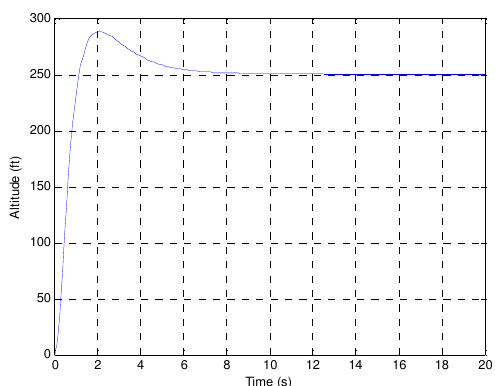
Fig . 9. Airspeed increase by change the throttle control.